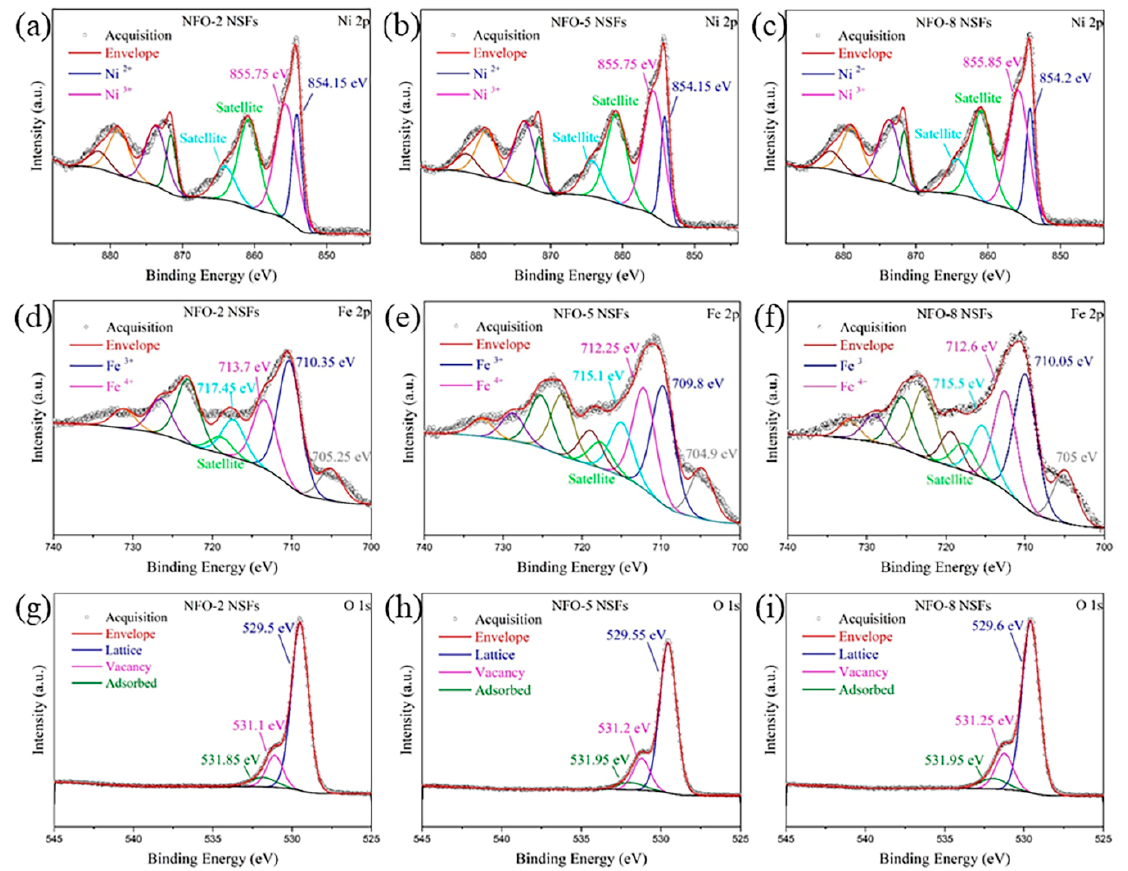
Figure 2. XPS Ni 2p spectra of ( a ) NFO-2, ( b ) NFO-5 and ( c ) NFO-8 NSFs; XPS Fe 2p spectra of ( d ) NFO-2, ( e ) NFO-5 and ( f ) NFO-8 NSFs; XPS O 1s spectra of ( g ) NFO-2, ( h ) NFO-5 and ( i ) NFO-8 NSFs.